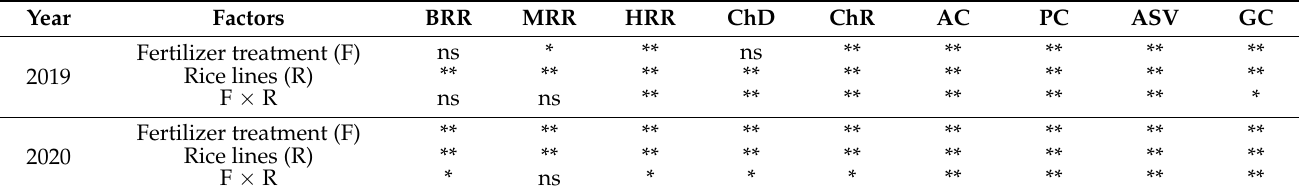
Table 2. Correlation analysis of different fertilizer treatments on quality of O8 and WT.